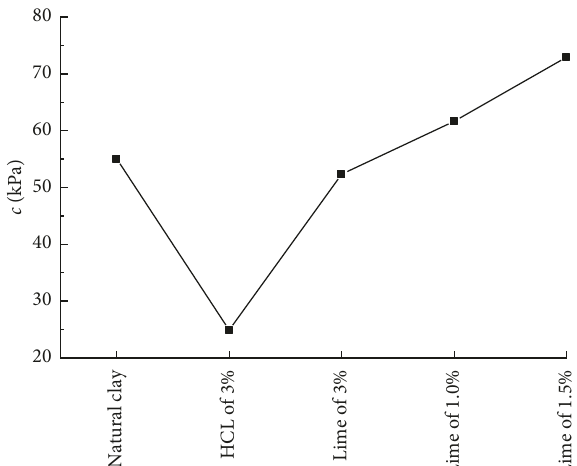
Figure 11: Variation in internal friction angle of lime-cured acid- contaminated